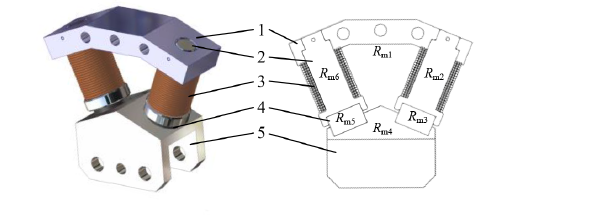
Figure 10. Fan-shaped MRE structure.